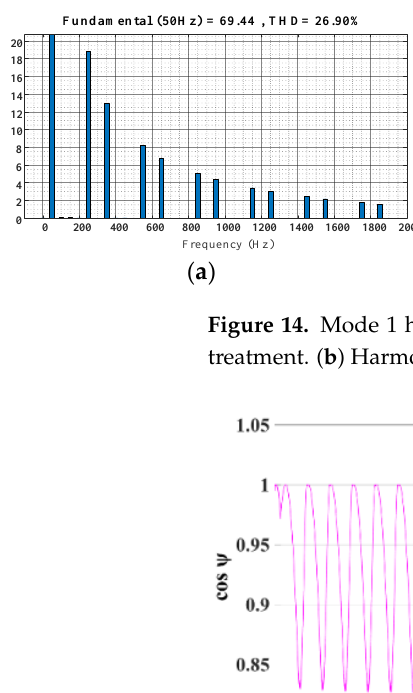
Figure 15. Mode 1 grid-connected power factor.